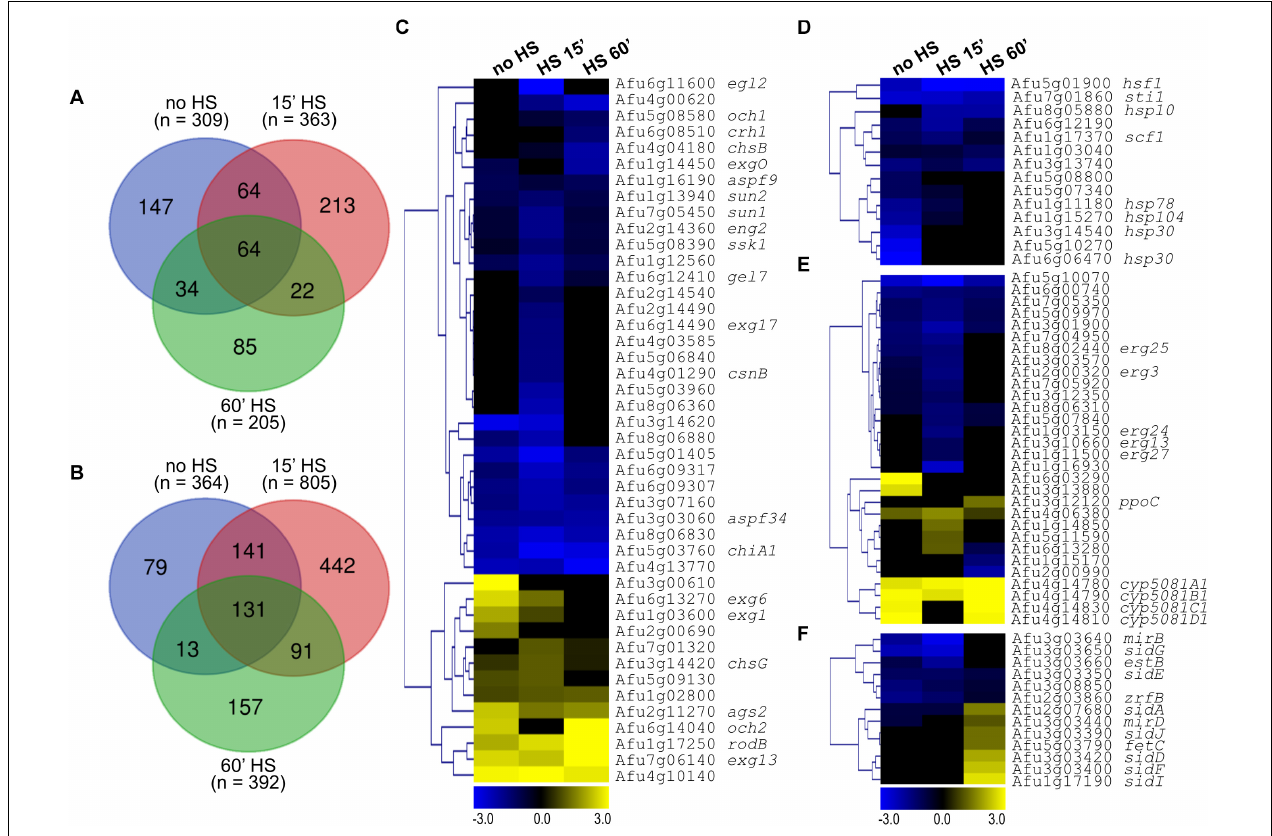
FIGURE 9 | hsfA repression impacts the expression of genes related to HS, cell wall, lipid, and iron metabolism. Venn diagrams comparing the genes upregulated (log 2 FC ≥ 1.0) (A) and downregulated (log 2 FC ≤ –1.0) (B) in the xylP::hsfA mutant strain relative to the wild-type strain at no HS condition and post-15 min or 60 min of HS. (C–F) Hierarchical clustering analysis showing selections of differently expressed genes (log 2 FC ≥ 1.0 or log 2 FC ≤ –1.0). The heat maps are divided by processes and categories of interest: cell wall biosynthesis and organization (C) ; heat shock response, chaperone activity, and protein folding (D) ; lipid metabolism (E) ; and iron metabolism (F) . All the heat maps were created in the Multiple Experiment Viewer (MeV) platform, using hierarchical clustering and Euclidean Distance with average linkage